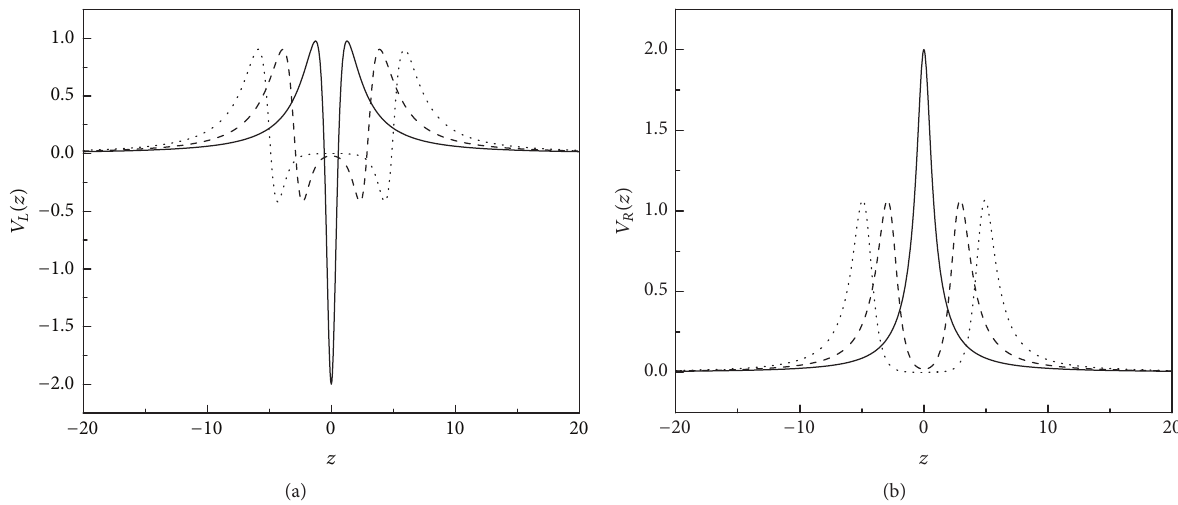
Figure 2: The shapes of potentials: (a) 𝑉 퐿 (𝑧) and (b) 𝑉 푅 (𝑧) , 𝑎 = 0 (solid line), 𝑎 = 3 (dashed line), and 𝑎 = 5 (dotted line).